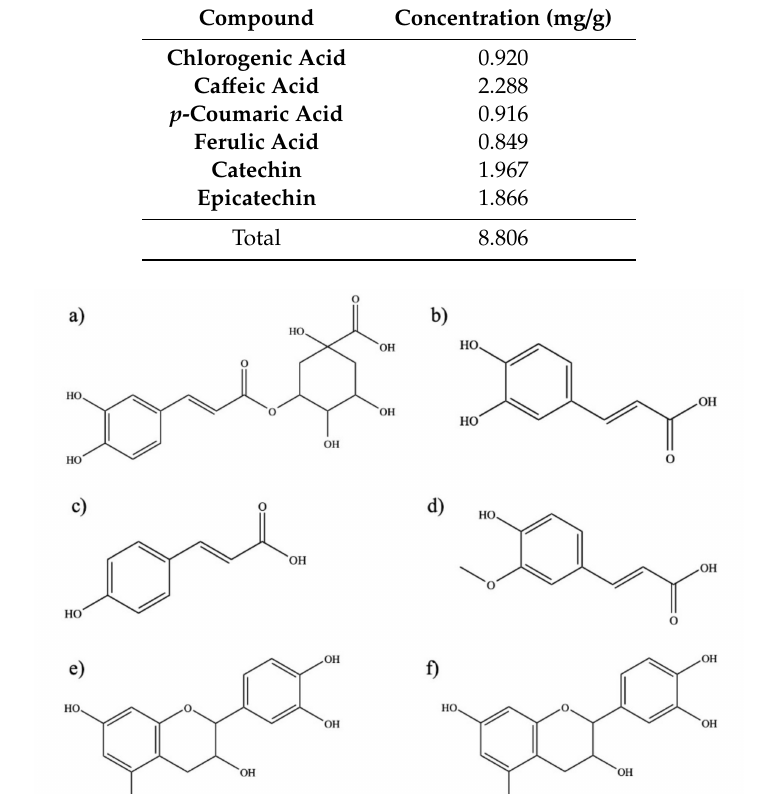
Table 2. Phenolic compounds identified by high-performance liquid chromatography (HPLC) extract on the methanolic extract of L. tridentata .